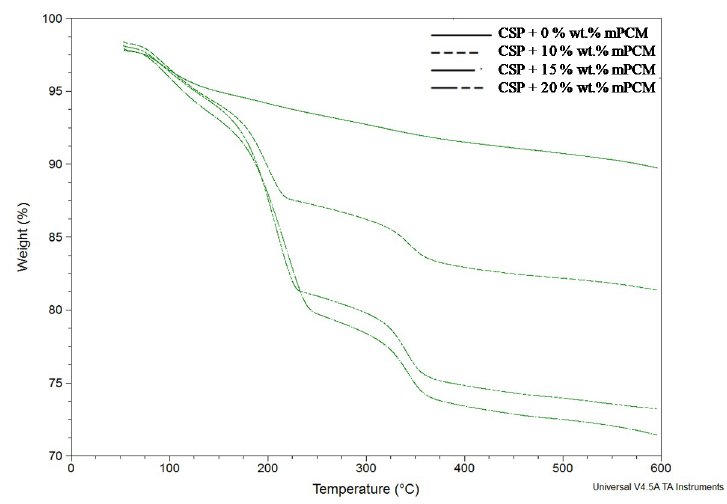
Figure 4. Thermogravimetric analysis (TGA) results comparison between the different formulations.